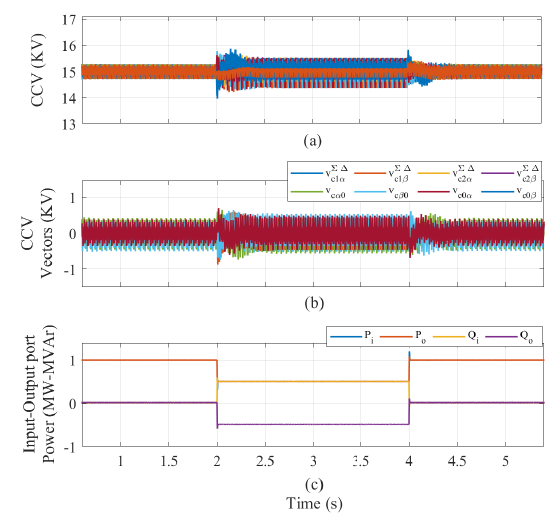
Figure 9. Test 1 results. ( a ) CCVs. ( b ) CCV vectors in the Σ∆ double- αβ 0 frame. ( c ) Active and reactive power at the M 3 C input and output ports.